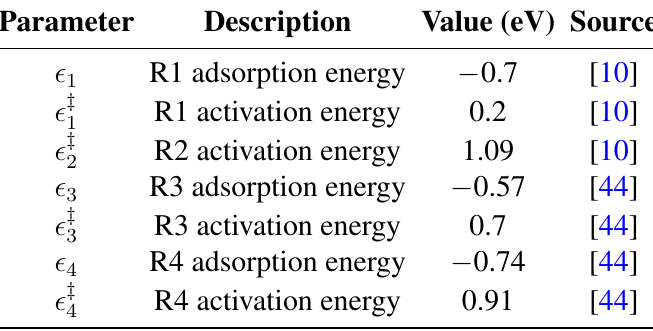
Table 3. Reaction rate energetics